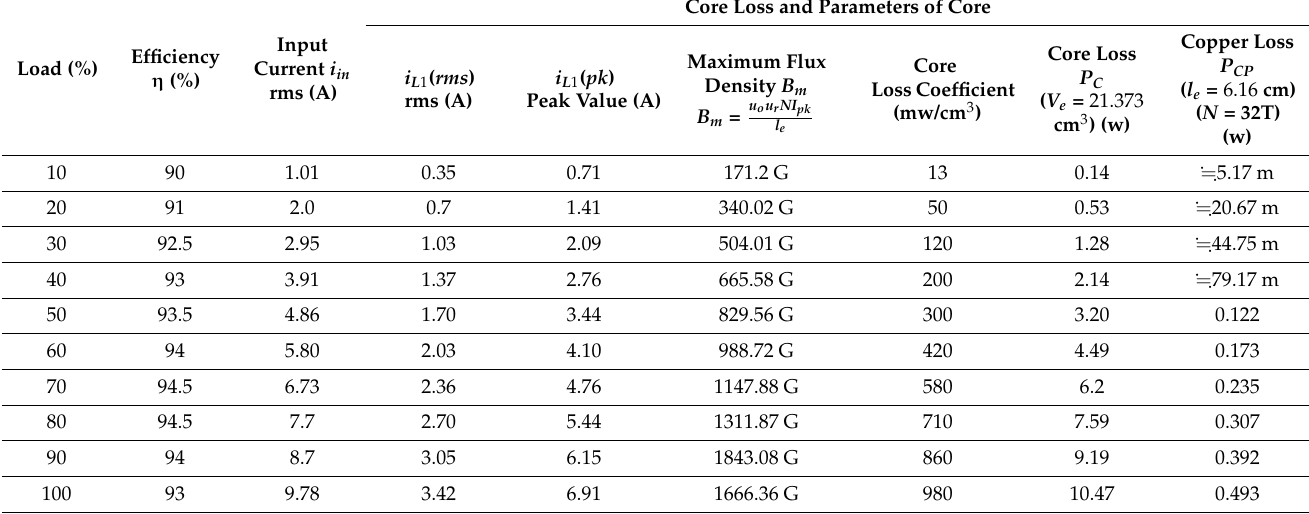
Table 5. Parameters of core and core loss analysis for the proposed converter.